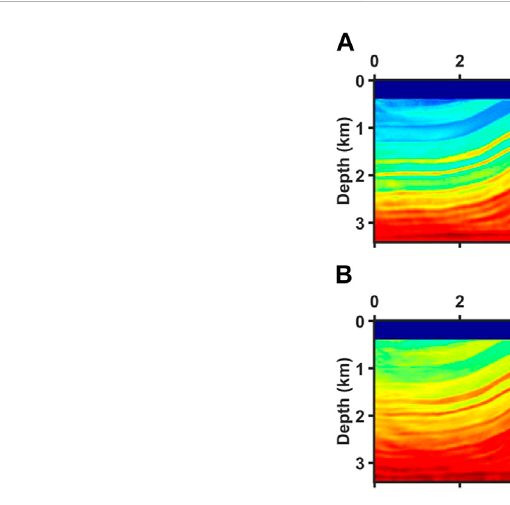
FIGURE 13 P-wave (A) and S-wave (B) velocity of cascaded